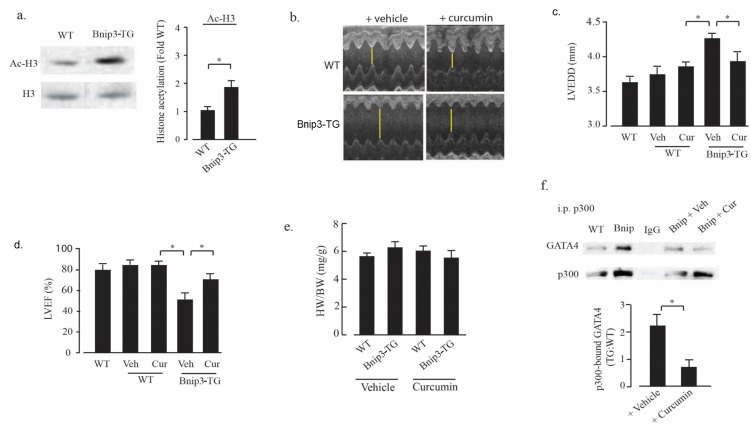
Curcumin treatment improves Bnip3-TG cardiac performance.(A) Histone H3 acetylation (Ac-H3) levels in left ventricular lysates from wild type (WT) and Bnip3-TG mice were measured and quantified as described in Methods. (n = 3; * p < 0.05). Example images of short axis M-mode echo cardiograms of WT and Bnip3-TG mice treated with either vehicle or curcumin as described in Methods (B). The effect of vehicle (Veh) or curcumin (Cur) treatment on echocardiographically determined left ventricular ejection fraction (LVEF), left ventricular end diastolic diameter (LVEDD), and heart weight to body weight (HW/BW) ratio of WT and Bnip3-TG mice is shown in (C–E). In (F) p300 was immunoprecipitated from the hearts of wild type (WT), Bnip3-TG, and Bnip3-TG mice treated with vehicle (Veh) or curcumin (Cur) and the association of p300 with GATA4 determined by western blot analysis. Quantitation of p300 bound GATA4 is shown below (*p < 0.05, n = 5). Results are mean ± S.E.M.